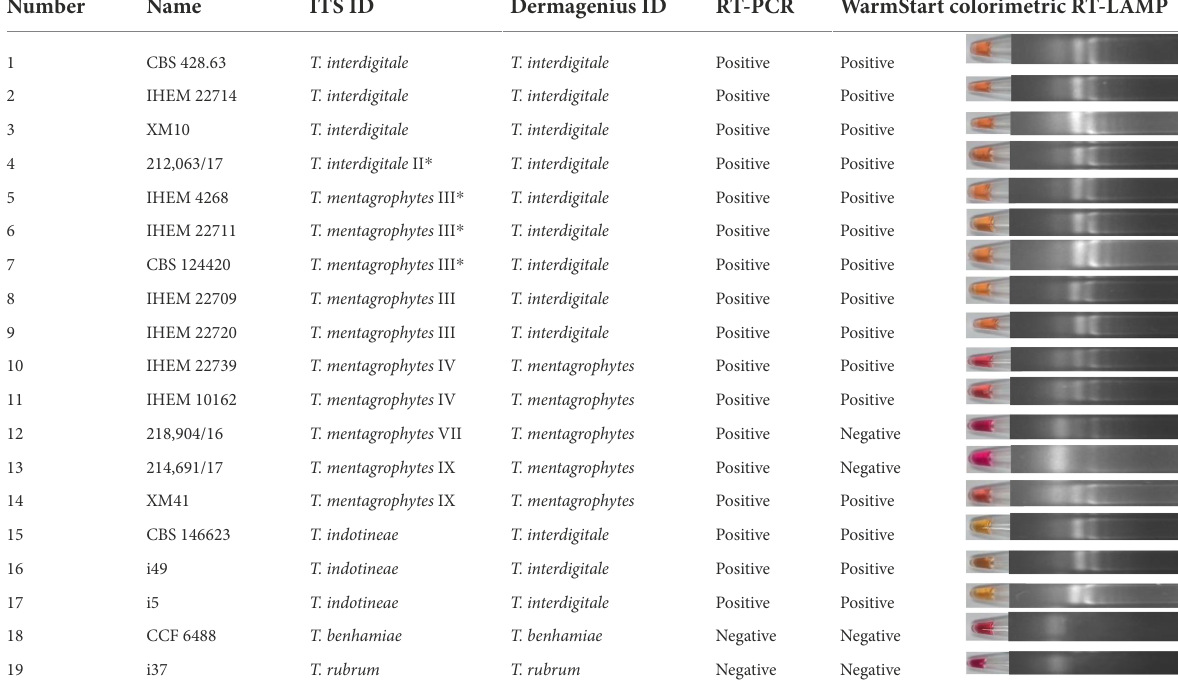
TABLE 2 Summary of the results related with genotypes detection based on different methods. Number